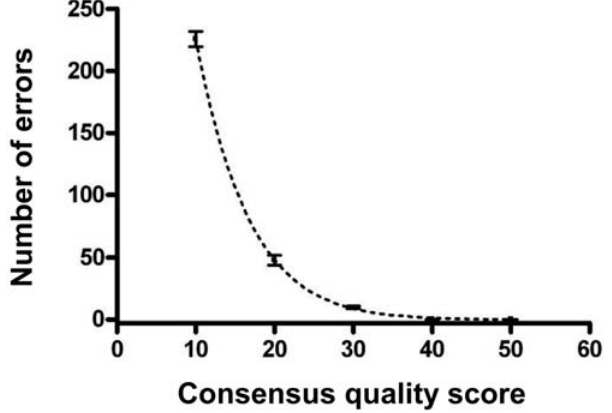
Figure 2. Quality analysis of sequences generated with the Illumina/Solexa platform. Sequencing errors were estimated by self- against-self comparison tests. Independent Solexa reads from a single 168 sample were randomly shuffled and split into two equal groups. Consensus sequences from these two groups were compared, and the experiment was repeated 10 times to calculate the average number of errors. The observed average number of errors decreased exponentially with the consensus quality score calculated by